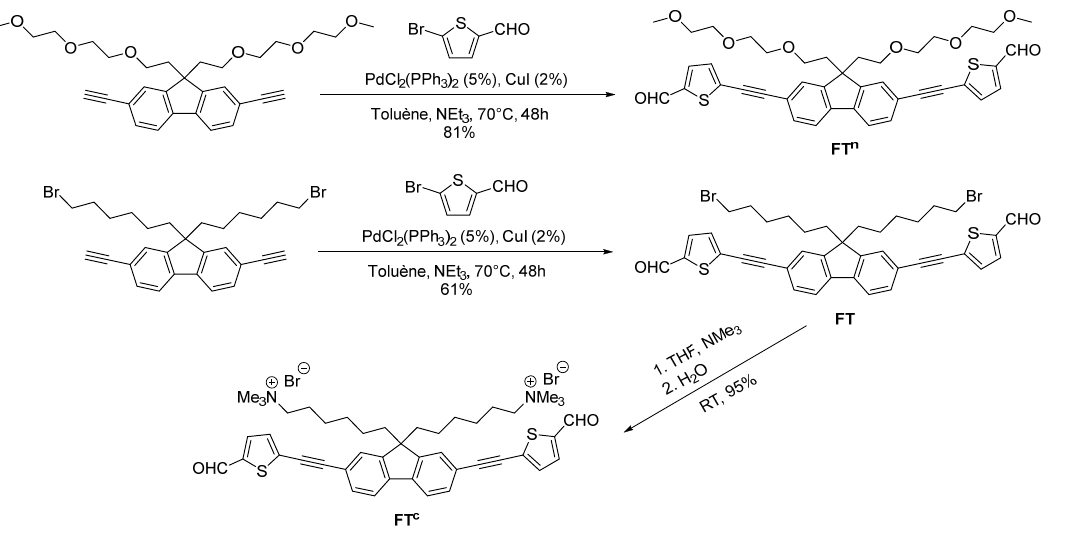
Figure 1. Schematic representation of the dynamic covalent polymer approach. The building blocks are fluorescent π -conjugated units (F, in red) and cationic arginine units (+, in green).